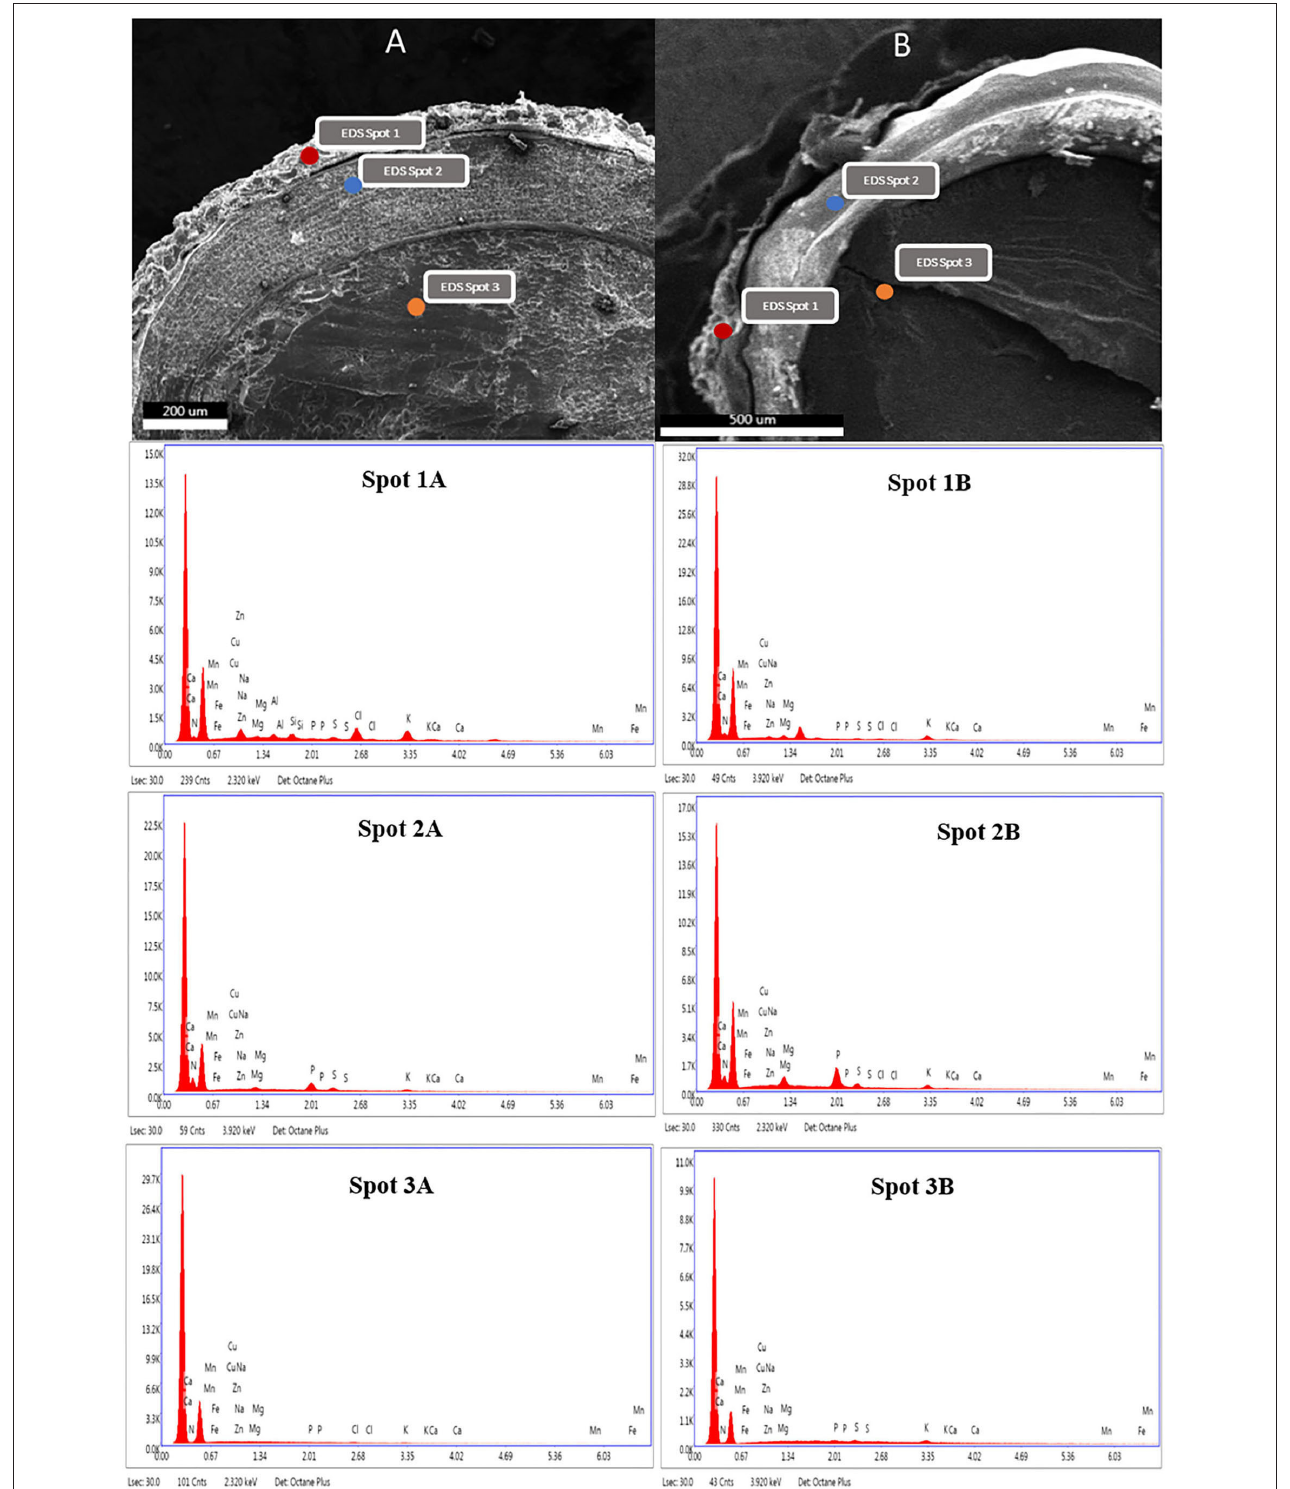
FIGURE 3 | SEM photographs of C. quinoa and EDX distribution of macro and microelements in the layers of non-washed (A) and washed (B) quinoa seeds. (Spot 1: pericarp, Spot 2: cotyledon, Spot 3: perisperm).